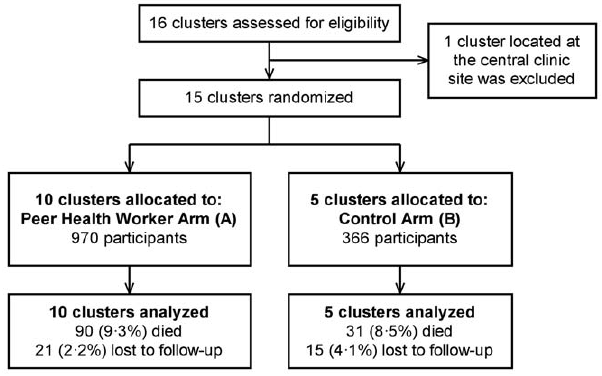
Figure 1. Trial profile.